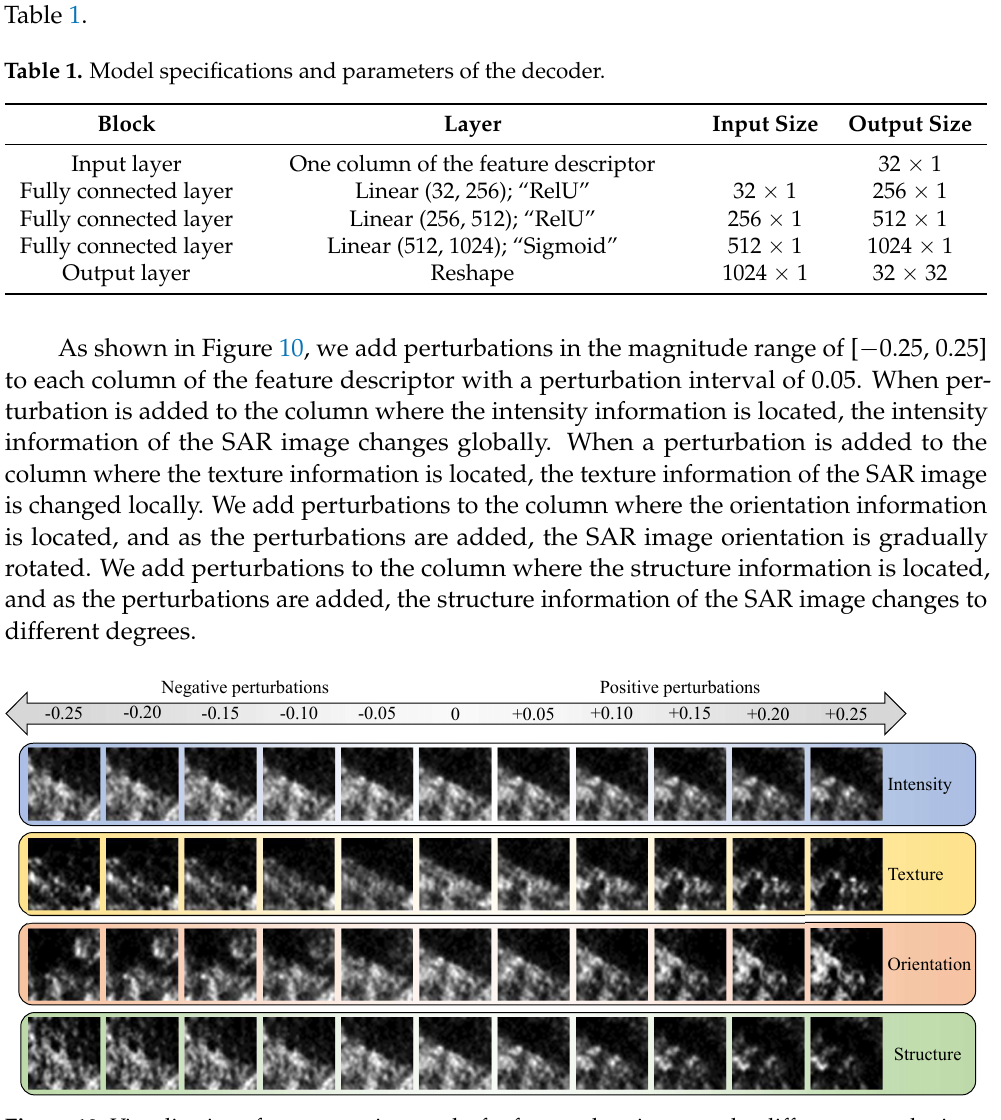
Figure 10. Visualization of reconstruction results for feature descriptors under different